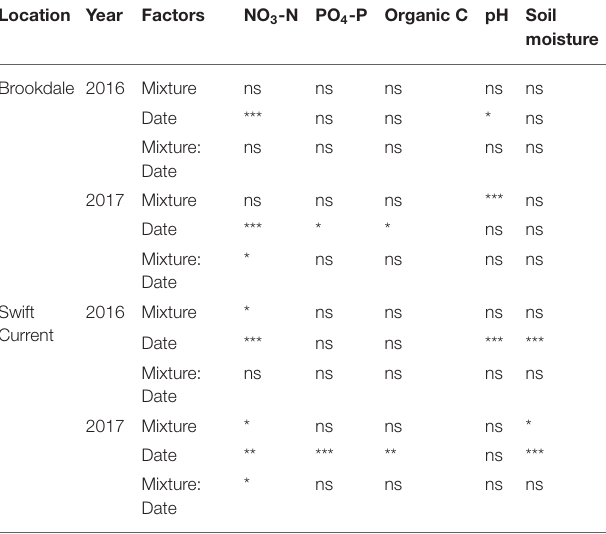
TABLE 4 | ANOVA results of the effect of cropping mixtures (monoculture, three, six, and nine spp.) and date of sampling (mid or late growing season) on bacterial and fungal α -diversity at the Swift Current and Brookdale research sites in 2016 and